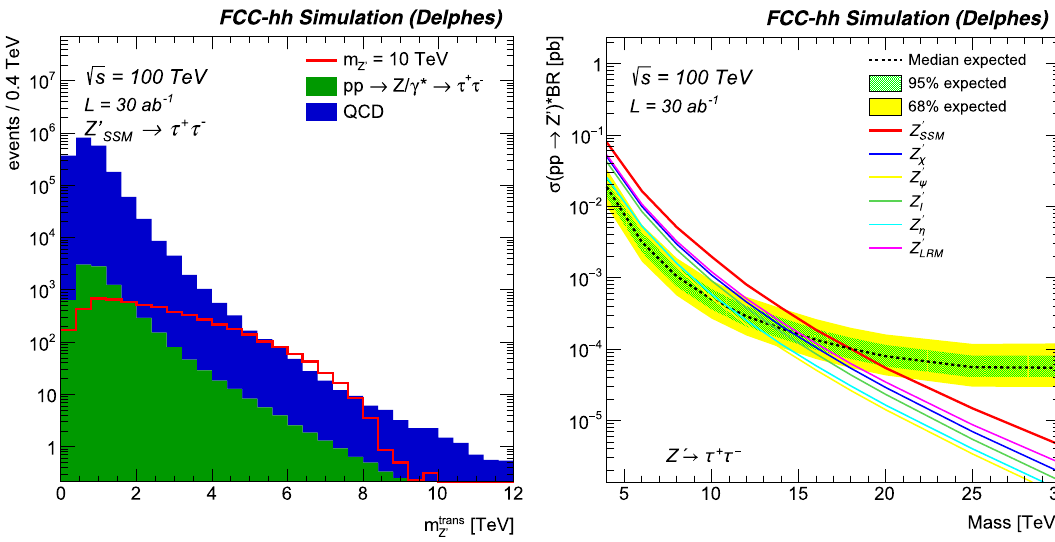
Fig. 3 Left: Di- τ transverse mass for a 10TeV signal after full event selection. Right: 95% CL limit versus mass